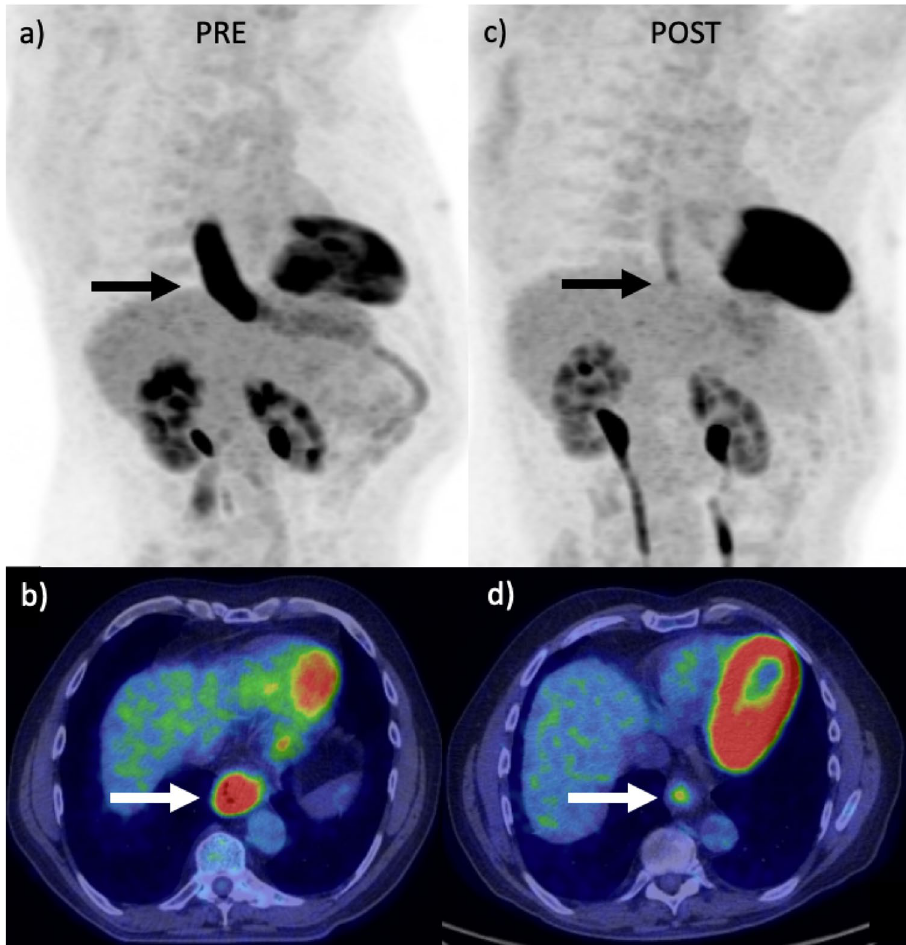
Figure 1. Selected images from a patient with a distal oesophageal adenocarcinoma. Maximum intensity projection (MIP) ( a ) and fused axial PET-CT images ( b ) demonstrated a large FDG-avid tumour. After neo- adjuvant chemotherapy was completed, a repeat PET-CT ( c , d ) showed there had been an excellent metabolic response. This patient had a positive DDIR assay and final pathological examination indicated a good response (tumour regression grade